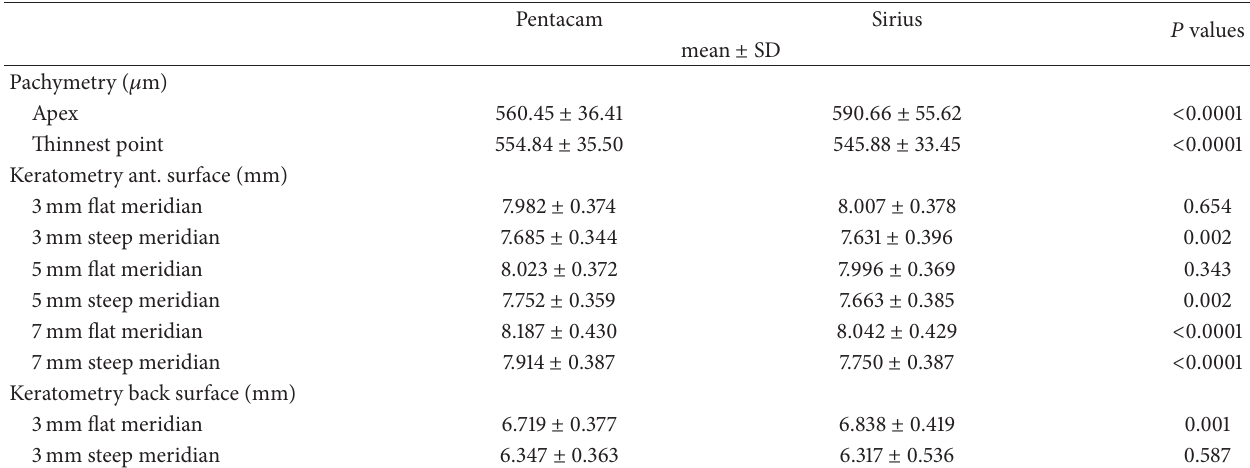
Table 5: Interdevice differences of the two devices in corneas with regular astigmatism.